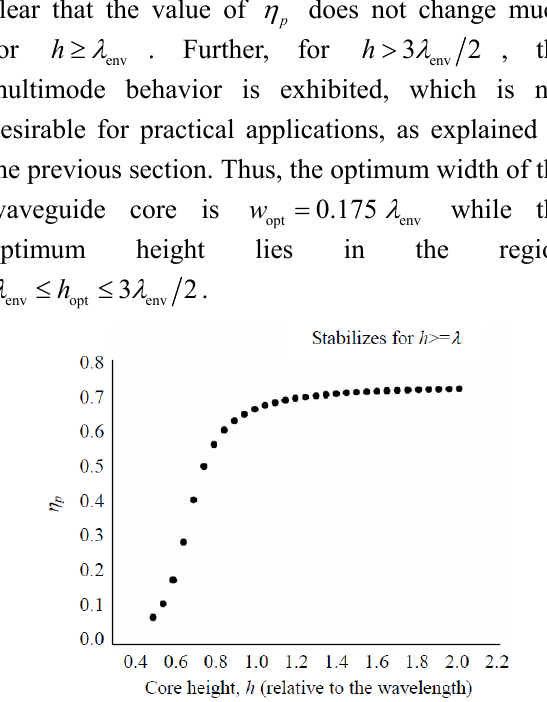
Fig. 2 Profile of the fundamental mode in a single core waveguide in the case of (a) both cases the waveguide width is